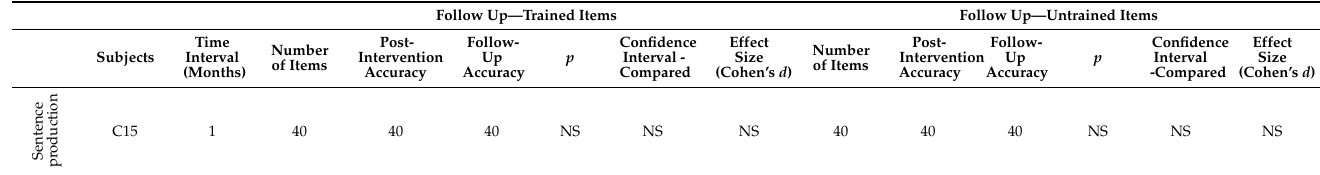
Table 5. Results from the follow-up